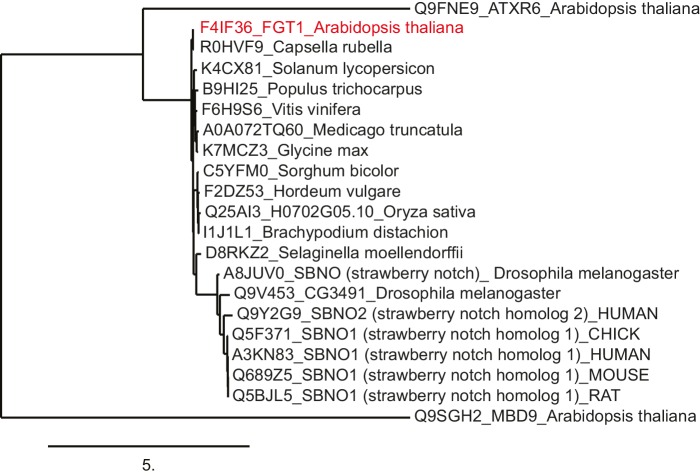
FGT1 is highly conserved and encodes the SNO/SBNO orthologue of A. thaliana.Phylogenetic tree generated using the www.phylogeny.fr website with the preset 'one-click' settings. Sno/SBNO/FGT1 sequences were identified using BLAST searches with the full-length FGT1 protein. A. thaliana MDB9 and ATXR6 were used as outgroups as they displayed the highest hits from A. thaliana in a BLAST against full-length FGT1.